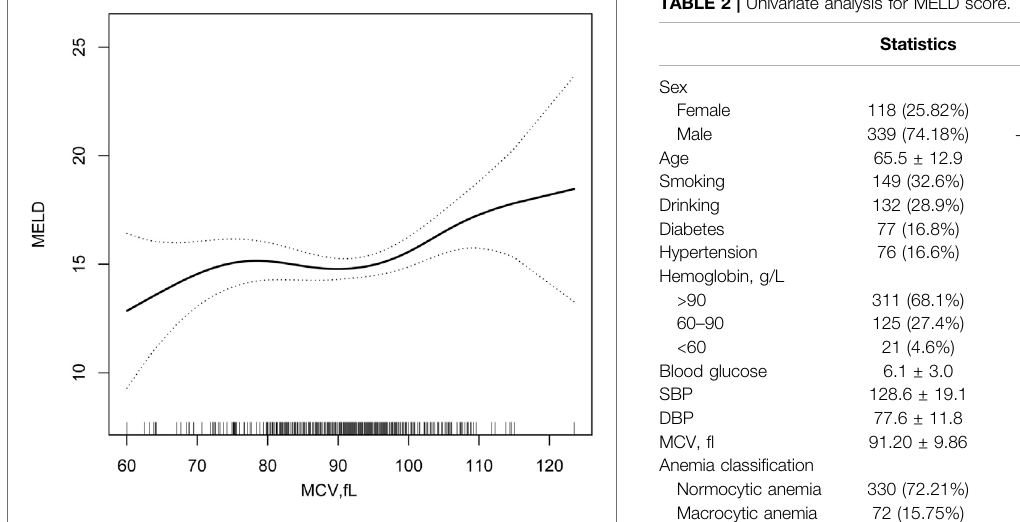
FIGURE 2 | Two-piece piecewise regression and smooth curve- fi tting for association between MCV and MELD strati fi ed.